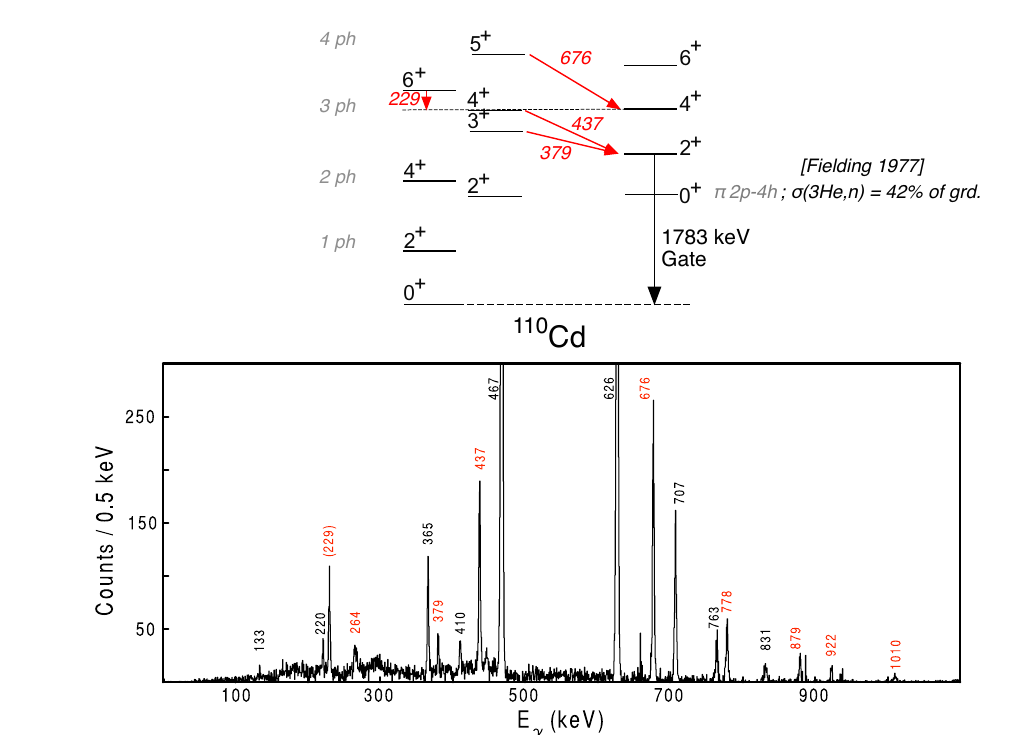
Figure 1. A partial level scheme and γ -ray spectrum of 110 Cd following 110 m Ag β decay and a gate on the 1783-keV γ -ray transition (a 1 . 1 × 10 − 4 per β decay branch [10]). The new transitions are labeled by energy in red ; the 229-keV γ ray was recently reported for the first time by Garrett et al. , [6]. These new transitions are incredibly weak. For instance, the 379-keV transition has a decay branch of roughly 1 in 200,000 β